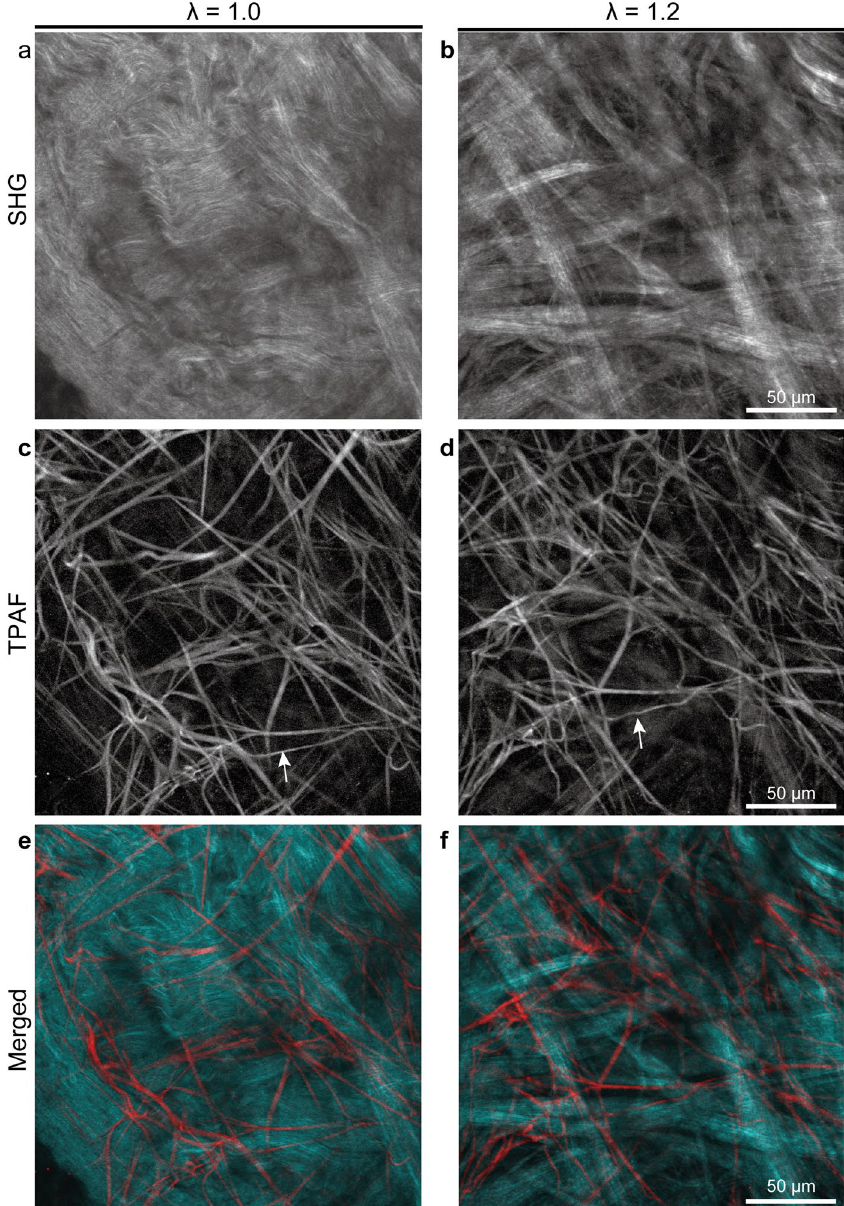
Figure 7. Dynamic multiphoton microscopy images of periadventitial architecture under biaxial tissue extension. Second harmonic generation (SHG) images show architectural changes in collagen fibers ( a , b ) whereas two-photon autofluorescence (TPAF) images show architectural changes in elastic fibers ( c , d ). λ represents the stretch ratio. Arrows of the same shape indicate the same elastic fiber. Note that collagen architecture changed from a tightly packed appearance to a basket weave-like appearance with